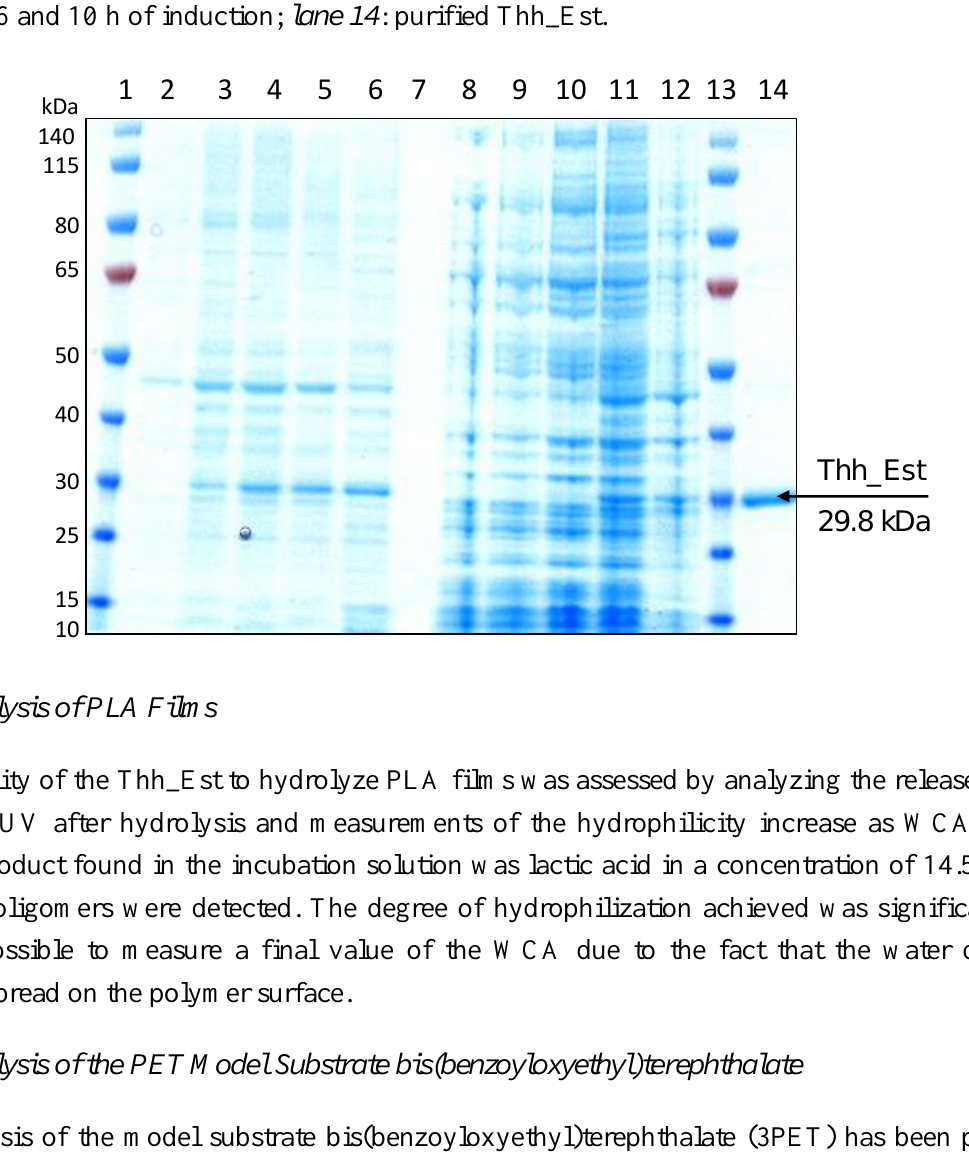
Figure 2. SDS-PAGE analysis of Thh_Est expressed in E. coli BL21-Gold (DE3). Samples were withdrawn at different times of induction, centrifuged, disrupted and centrifuged again. Lane 1 and 13 : PageRuler Prestained Protein Ladder (Fermentas); lane 2-6 : cleared lysates from induced cells after 0, 3, 6 and 10 h of induction with 0.05 mM IPTG; lane 7 : empty; lane 8-12 : insoluble cell fractions from induced cells after 0, 3, 6 and 10 h of induction; lane 14 : purified